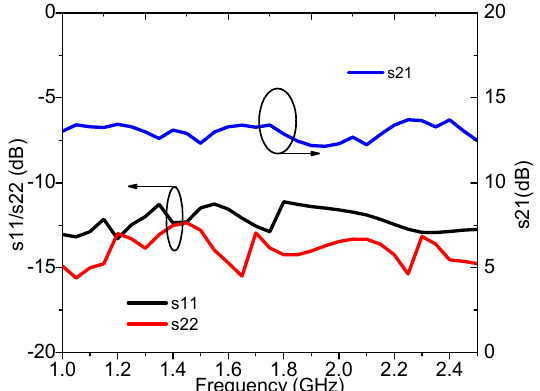
Figure 17. Measured s11, s22, and s21 of the designed DPA.